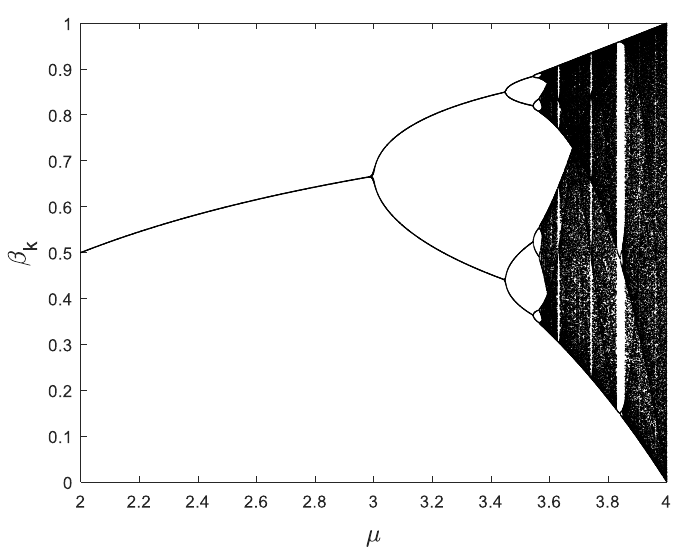
Figure 5. The bifurcation diagram of the logistic map.